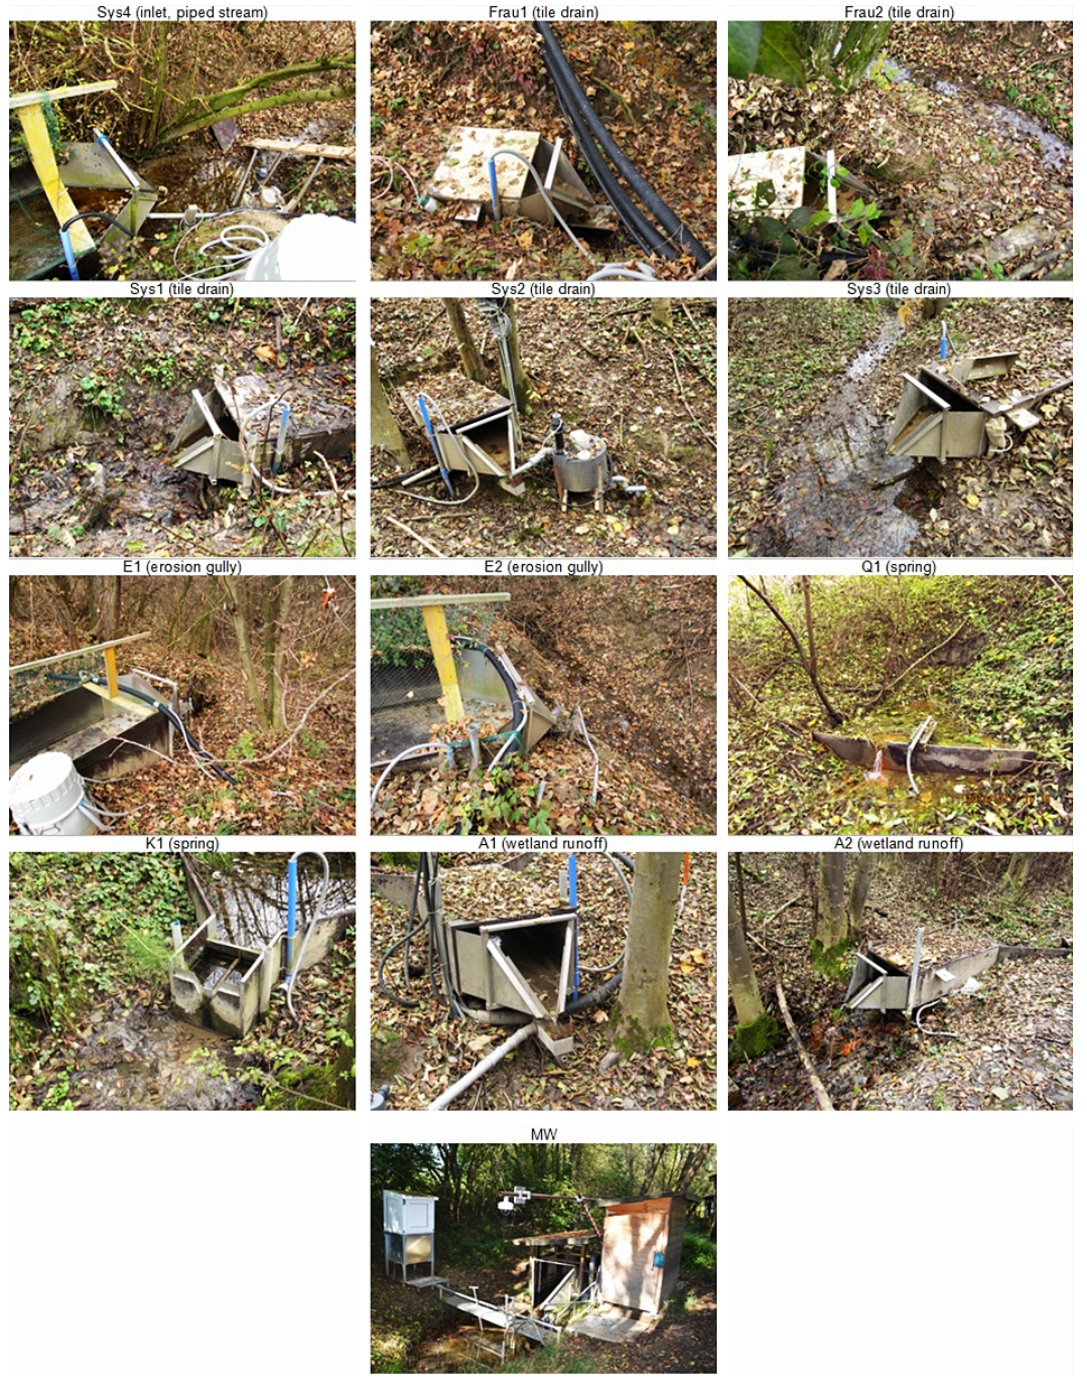
Figure C1. Photos of the 13 stream gauges in the